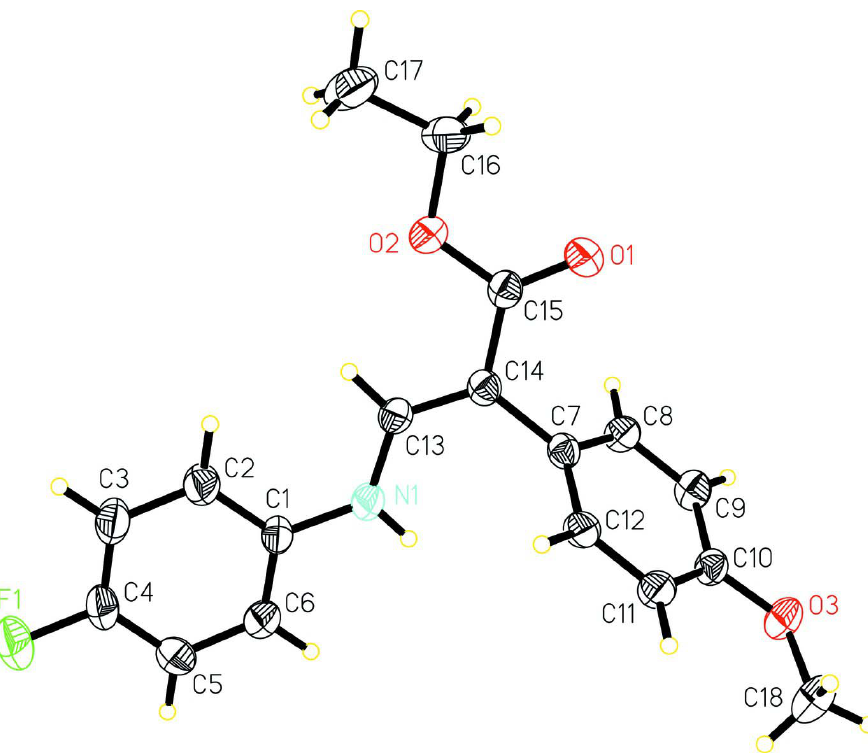
Figure 1 The molecular structure of the title compound, showing the atom-numbering scheme. Displacement ellipsoids are drawn at the 30% probability level.